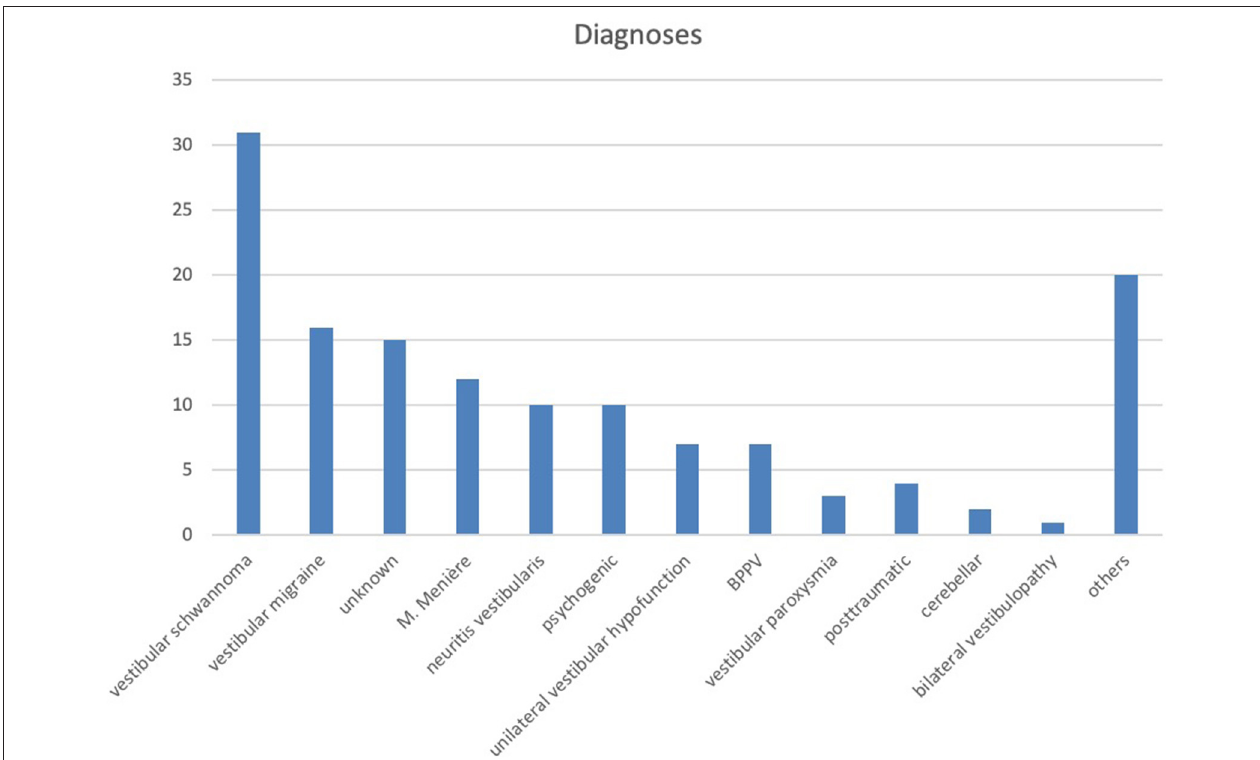
FIGURE 1 | Distribution of diagnosis among patients who fulfilled the inclusion criteria. Others: polyneuropathy, ocular vertigo, mal de debarquement, orthostatic dizziness, cerebral bleeding, meningioma, Wernicke’s encephalopathy.